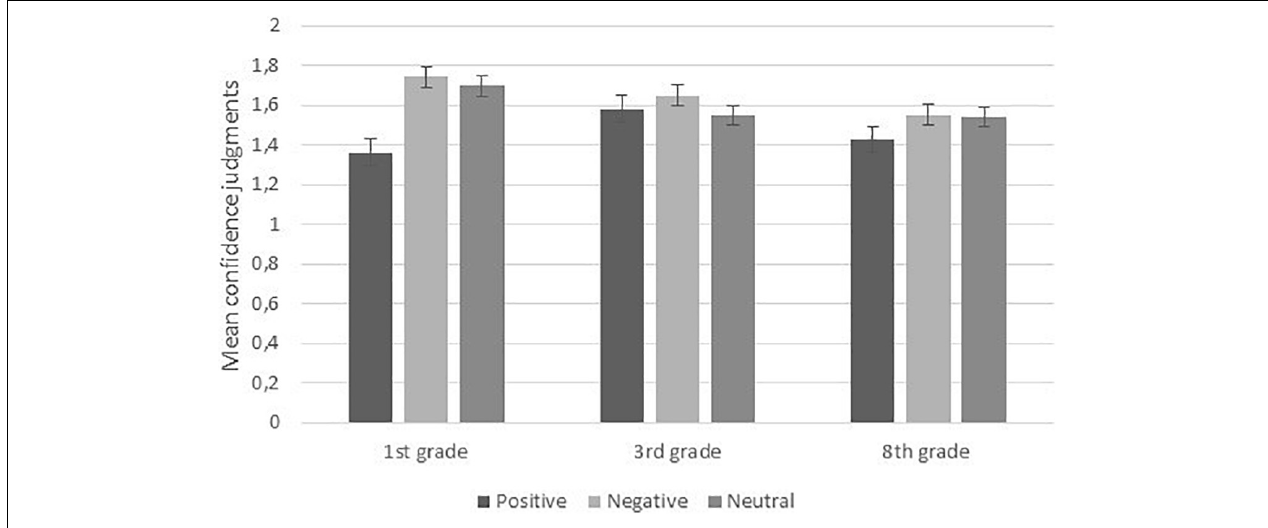
FIGURE 2 | Mean confidence judgments associated with causal errors as a function of emotional valence and grade. Bars represent standard errors.